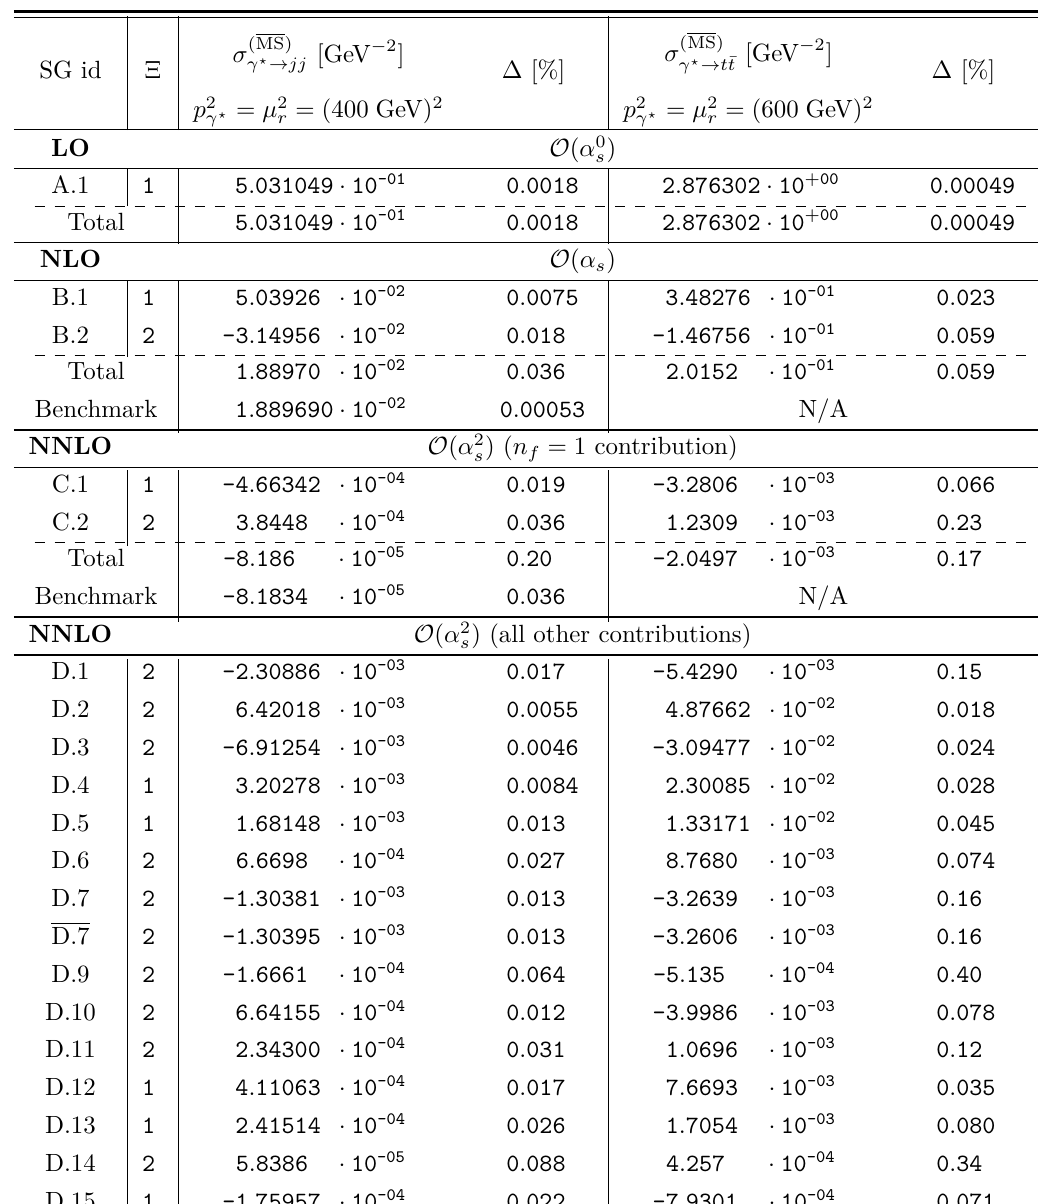
Table 2. Contributions from individual supergraphs listed in table 12 to the cross-section up to order O ( α 2 ) (LO+NLO+NNLO) for the processes γ ? → jj and γ ? → t ¯ t with n s and SM parameters as given in table. 1. Ξ denotes the symmetry factor of the supergraph (included in the result reported). ∆ reports the relative Monte-Carlo error, except for the “Benchmark” entry [106] where it refers to the relative difference w.r.t. the LU result